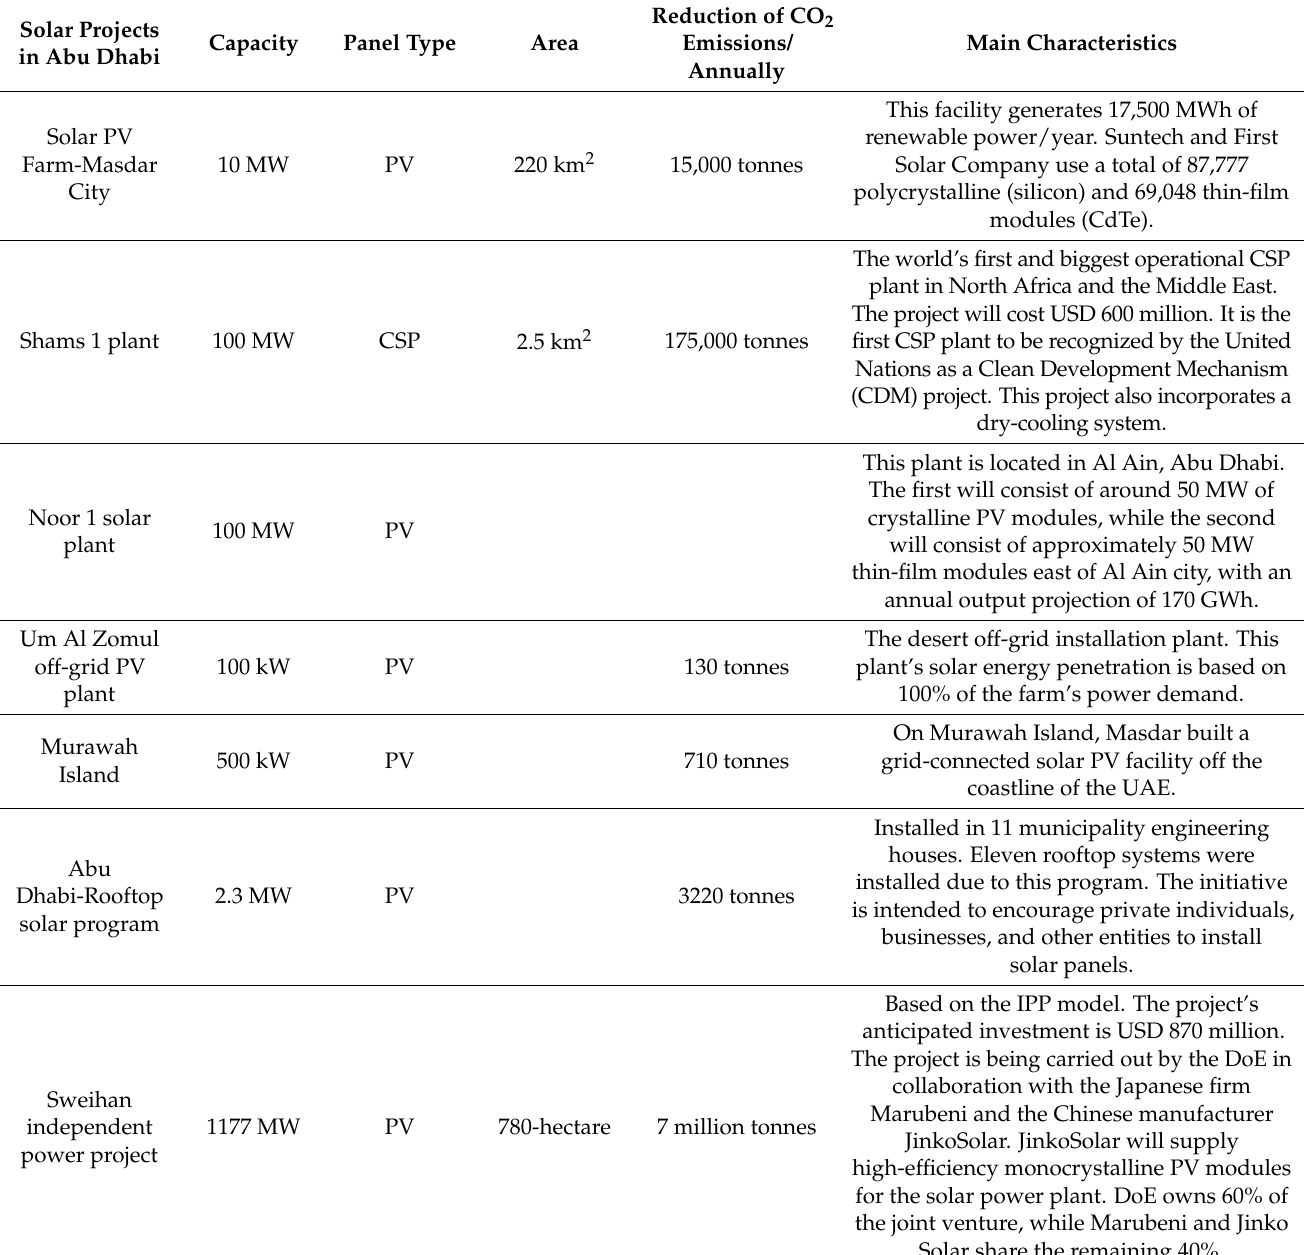
Table 4. List of solar energy projects in Abu Dhabi emirate with main